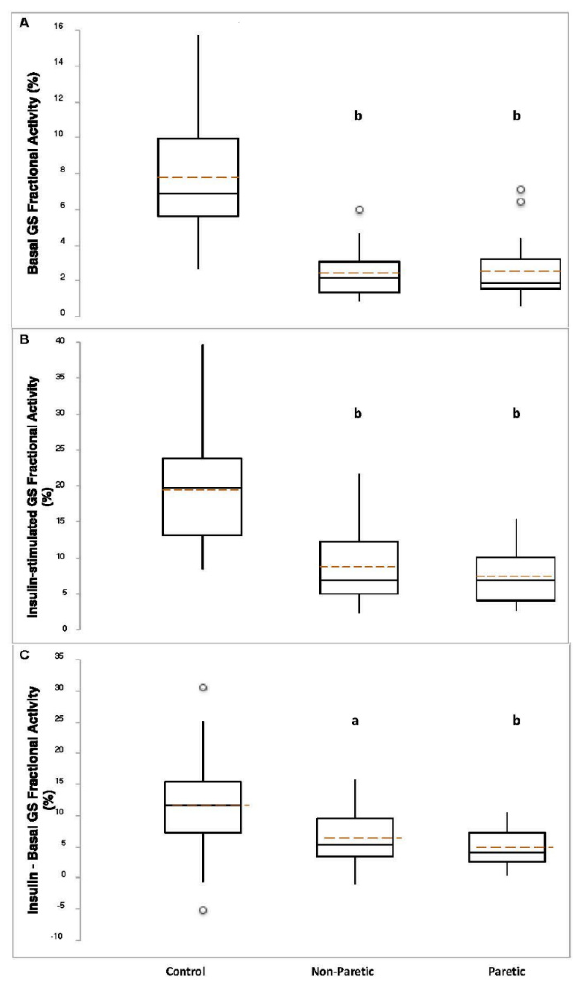
Figure 2. Basal panel ( A ), insulin-stimulated panel ( B ), and absolute change panel ( C ) GS fractional activities in control ( n = 28–35), nonparetic ( n = 26–35), and paretic ( n = 26–35) muscle samples. Boxplot legend: height of box = interquartile range (IQR); top of box = the 75th percentile (Q3); bottom of box = the 25th percentile (Q1); solid center line = median; dashed red line = mean; vertical line = range of data; open circles = outliers (< Q1-[1.5*IQR] or > Q3+[1.5*IQR]). Welch’s ANOVA with Welsh’s pairwise probabilities. a, p < 0.0005; b, p < 0.00001 compared to